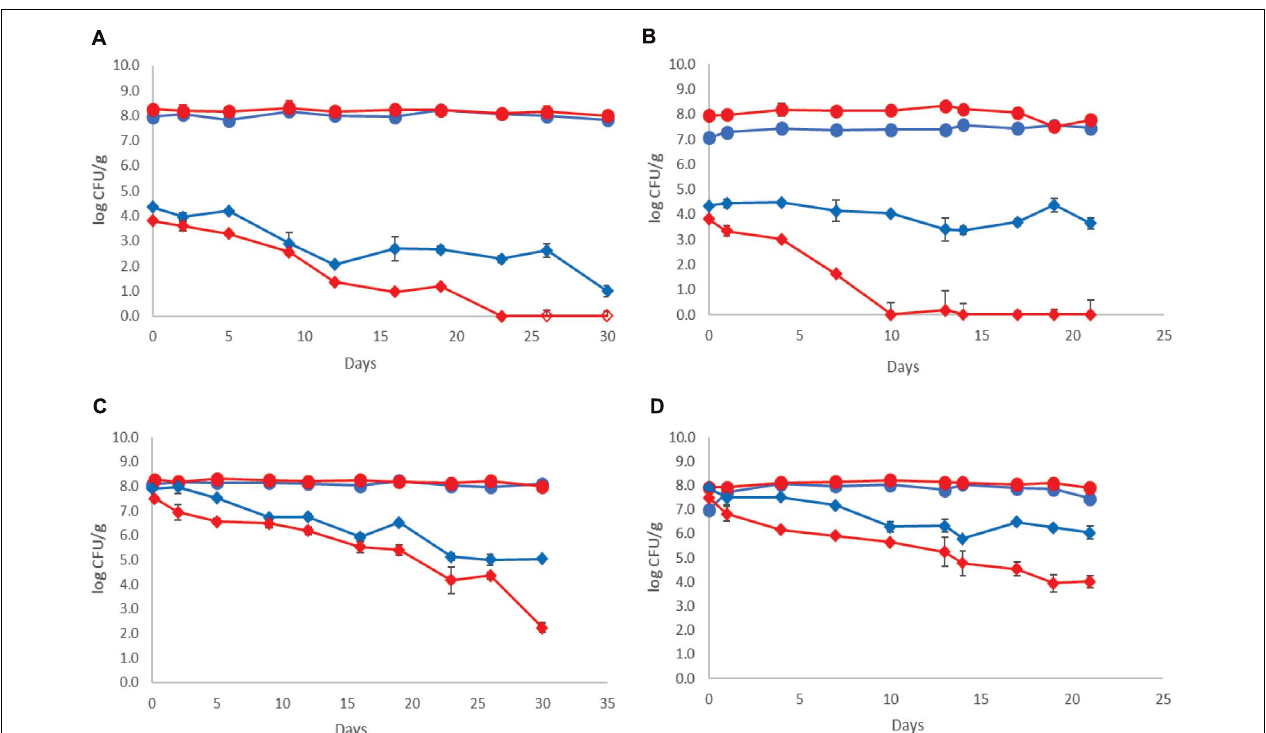
FIGURE 2 | Growth curves of total viable counts without ( • ) and with ( • ) addition of Lb. plantarum T571 and growth curves of Listeria monocytogenes cocktail strains without ( (cid:7) ) and with ( (cid:7) ) addition of Lb. plantarum T571 during storage of yogurt; (A) low inoculum, 4 ◦ C, (B) low inoculum, 12 ◦ C, (C) high inoculum, 4 ◦ C, and (D) high inoculum, 12 ◦ C. Open symbols ( ♦ ) indicate absence of Lb. monocytogenes after applying enrichment method. Bars represent mean values ± standard deviations (two biological samples, each sample analyzed three